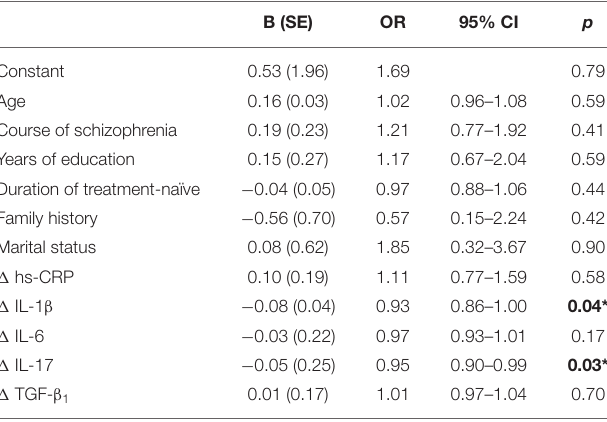
TABLE 5 | Factors predictive of efficacy in patients after 4 weeks of treatment: logistic regression